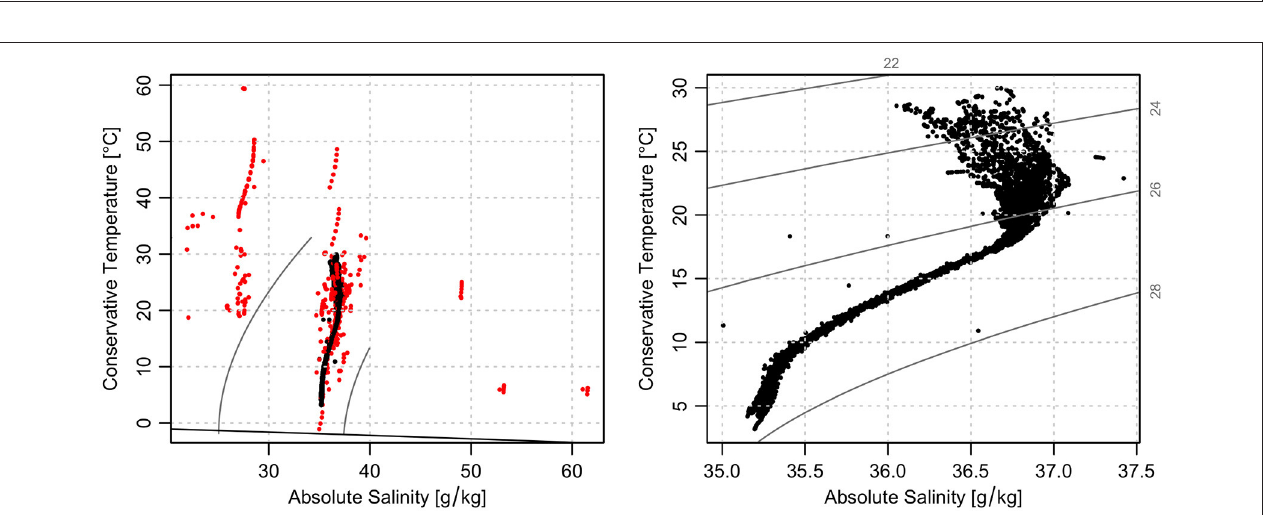
FIGURE 7 | Effect of handling Argo QC flags for float 1901584 using applyQC() . (Left) temperature-salinity diagram showing all data, colored red if the QC flags indicate “bad” values with QC flag codes 3 (Probably bad data that are potentially correctable), 4 (Bad data), 6 (Not used), or 7 (Not used). (Right) similar diagram, but narrowed to data flagged as good. In the latter, note the existence of several points that depart widely from the data cloud, even though the QC flags have been accounted for.